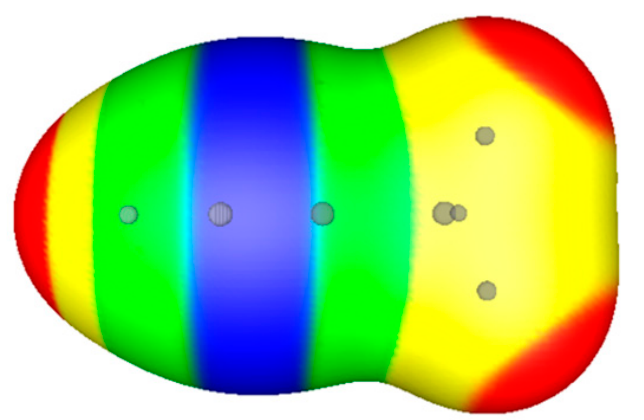
Figure 4. Computed electrostatic potential on 0.001 au surface of propyne, HC ≡ C-CH-CH 3 . Circles indicate positions of nuclei. The methyl group is at the right. Color ranges, in kcal/mol, are—red, more positive than 12; yellow, between 12 and zero; green, between zero and − 15; blue, more negative than − 15.